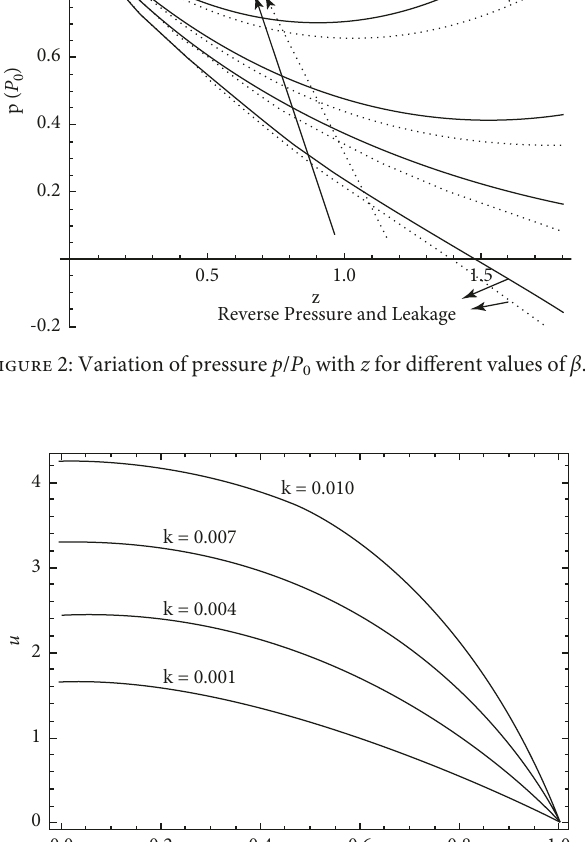
Figure 6: Variation of redial velocity v with r for different values of We 2 , where z � 0.1, P 0 � 43, K � 0.001, n � − 1, and m � 0.5.